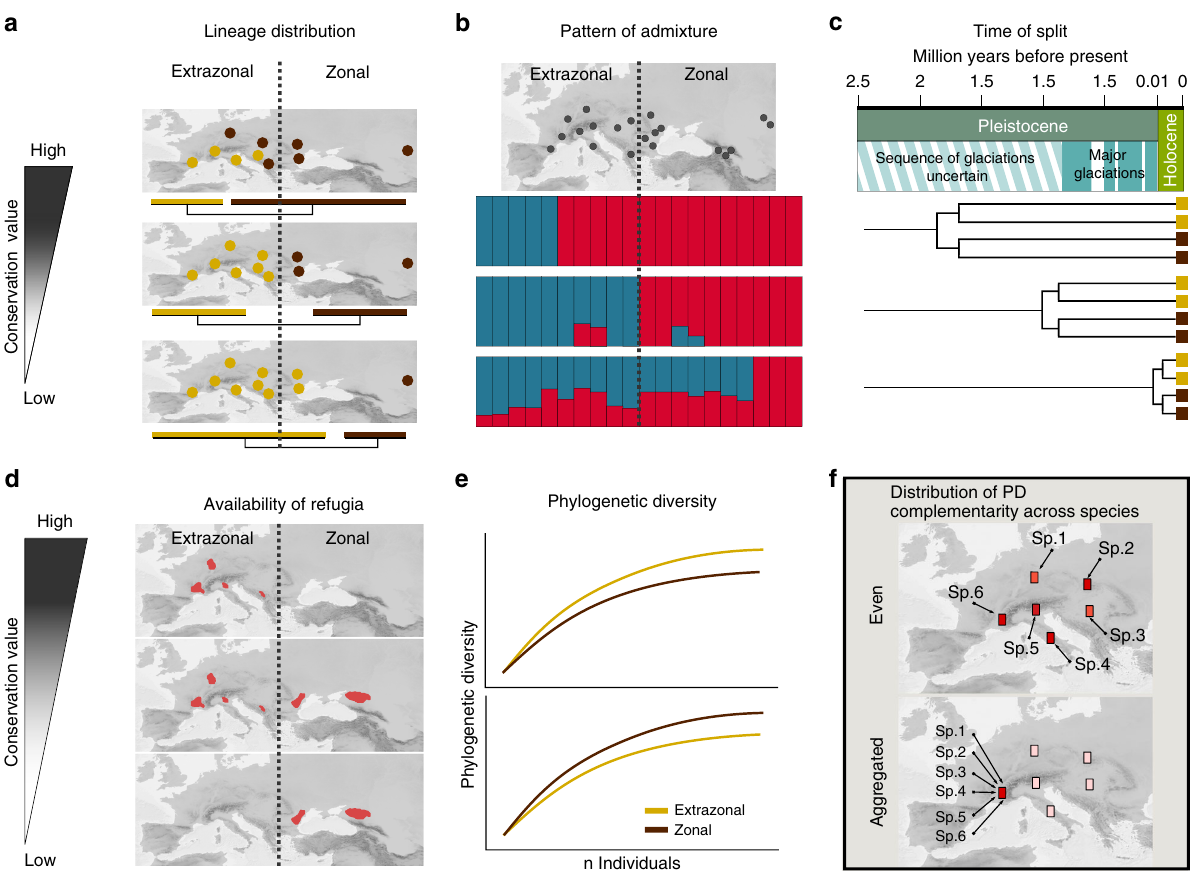
Fig. 2 Criteria chosen to evaluate the conservation value of biota of European extrazonal steppes. a Distribution of lineages throughout zonal and extrazonal steppes; populations illustrated as circles, colours represent origin of populations (yellow: extrazonal lineage, brown; zonal origin). b Geographic distribution of observed gene pools and admixture between them. c Time of lineage divergence (colour scheme as in ( a )). d Geographic position of refugia. e Phylogenetic diversity (yellow line: extrazonal, brown line: zonal). f Distribution of phylogenetic diversity complementarity (PD complementarity) across species (Sp.1 – 6) in the extrazonal steppes: even distribution of PD complementarity across species versus spatial aggregation of PD complementarity across all species in a single area (dark red: large value, light red: small value); the scale indicating conservation value does not apply in this fi gure